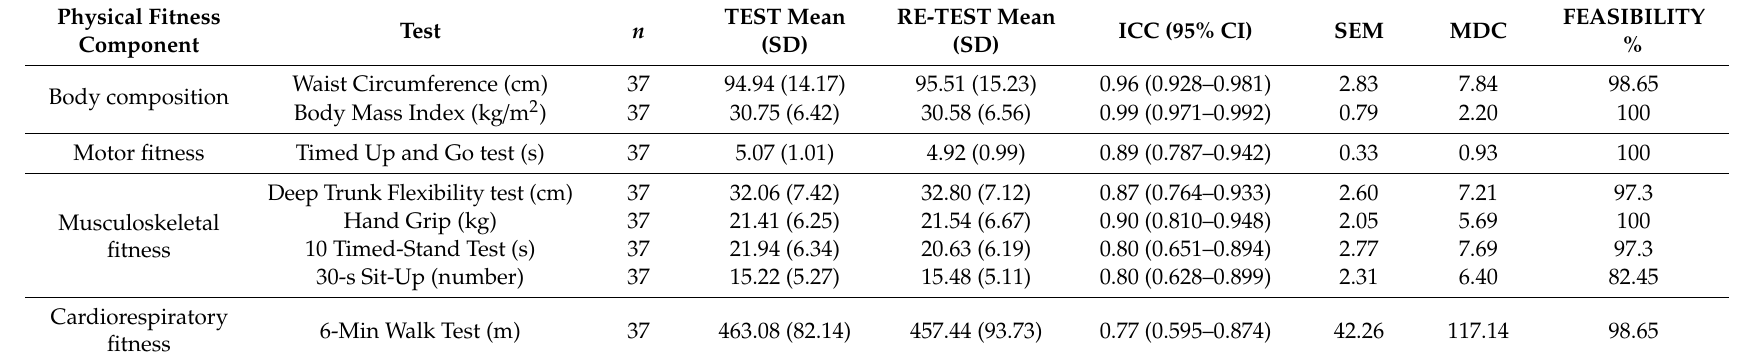
Table 1. Test–retest reliability in adults with Down